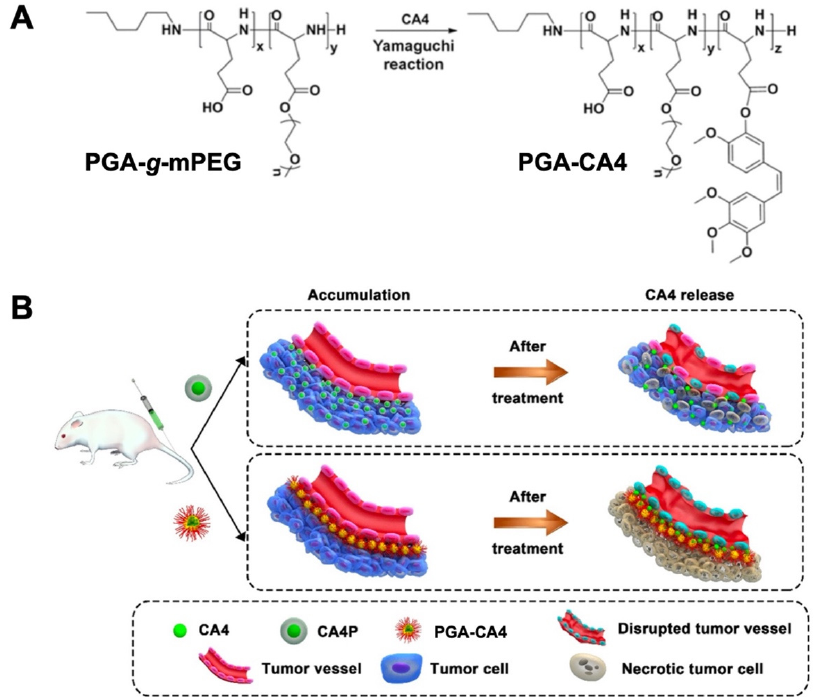
Figure 5. Comparation of the mechanism of PGA–CA4 and CA4P for the treatment of the murine colon C26 tumor cell. ( A ) Preparation of PGA–CA4 conjugate. ( B ) Mechanistic illustration of PGA- CA4 and CA4P toward tumor cells. Reproduced with permission. Reprinted with permission from Ref. [79]. Copyright 2017, Elsevier.